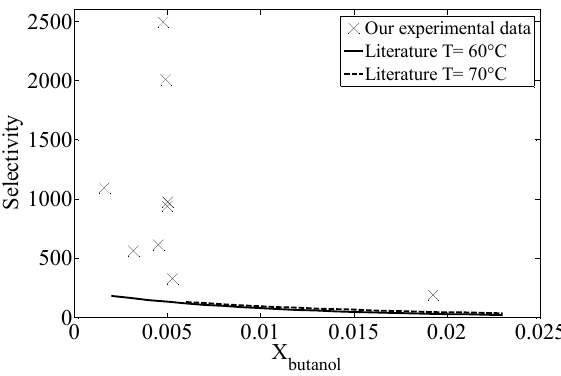
Figure 4. System CO 2 -water-butanol: selectivity of butanol calculated from reported data (60 and 70 °C) and comparison with the selectivity calculated from our experimental results.